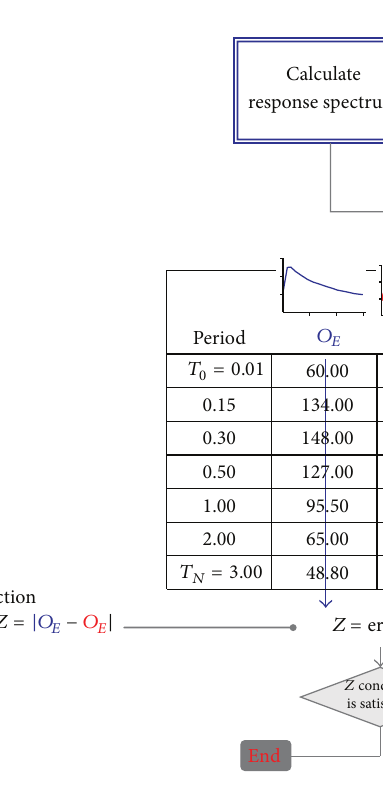
Figure 18: Iteration process of the genetic generator